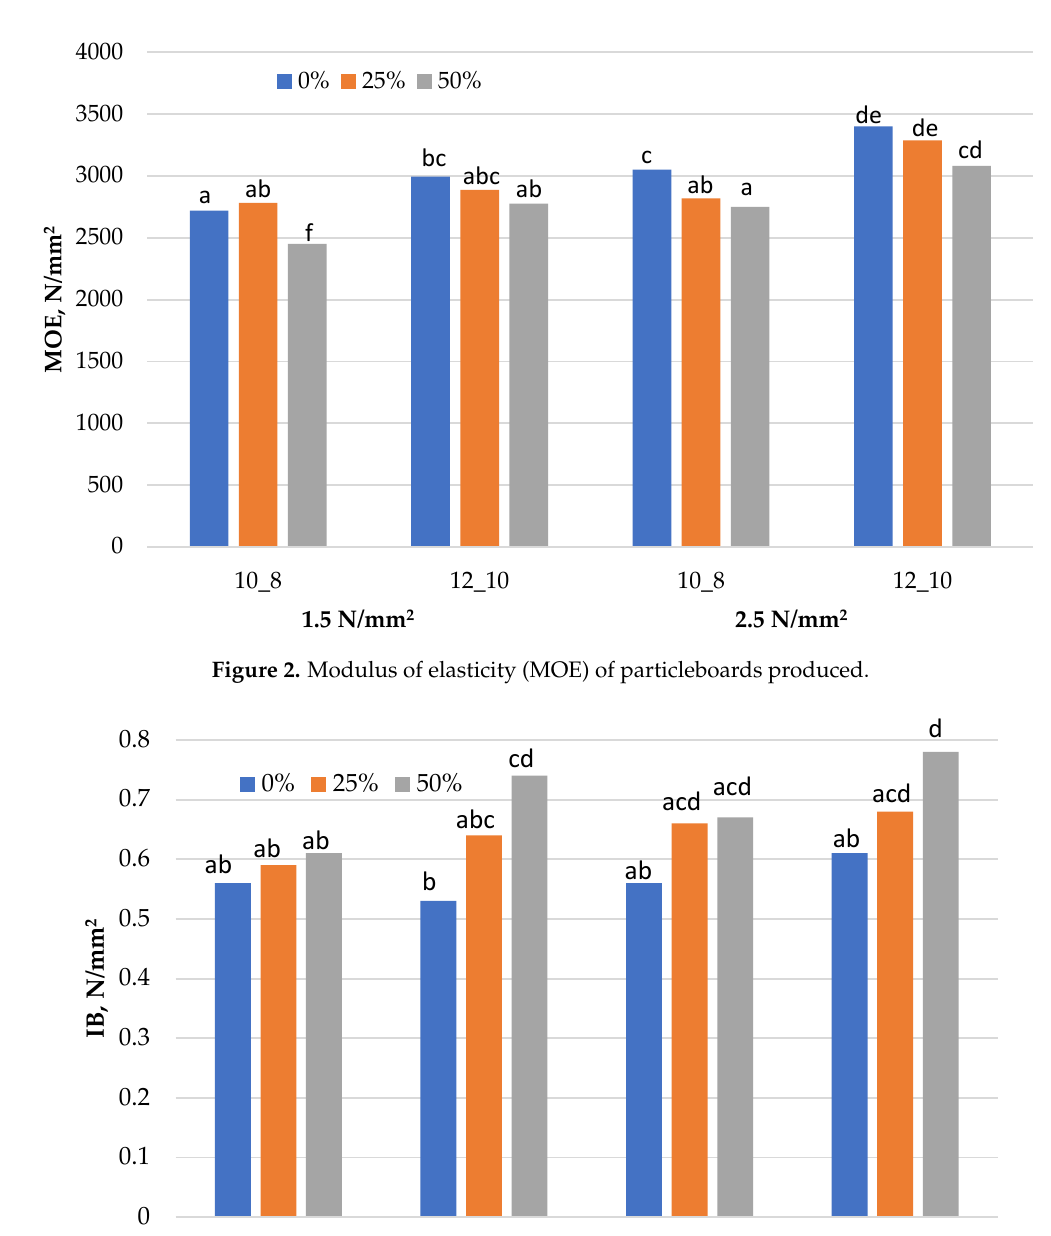
Figure 1. Bending strength (MOR) of particleboards produced.